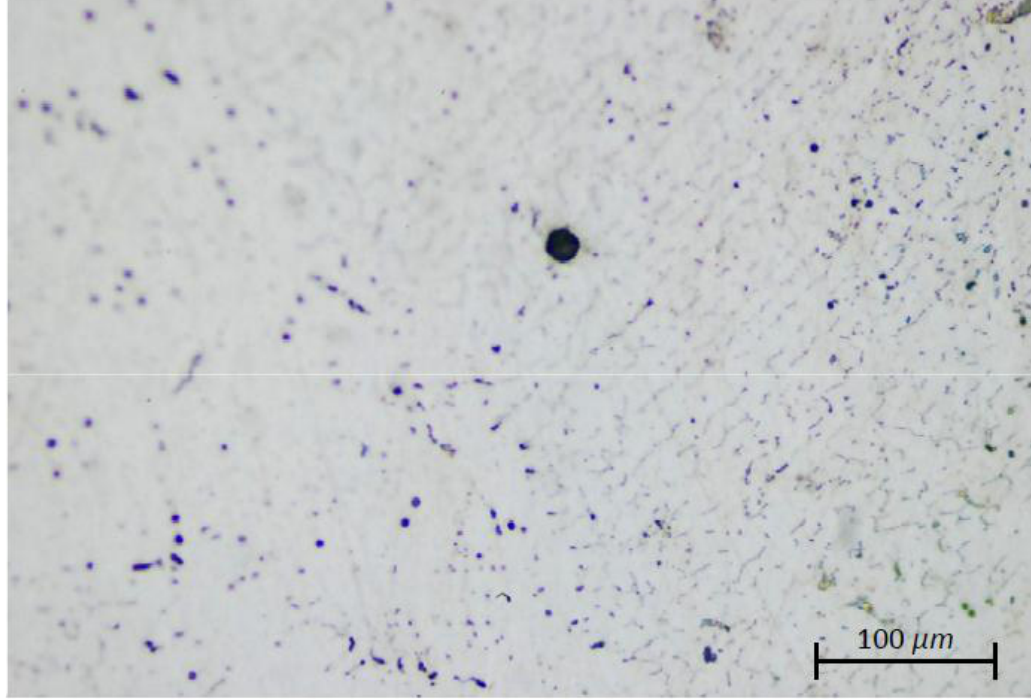
Figure 5. Micrograph of the material deposited on the ductile iron weld.